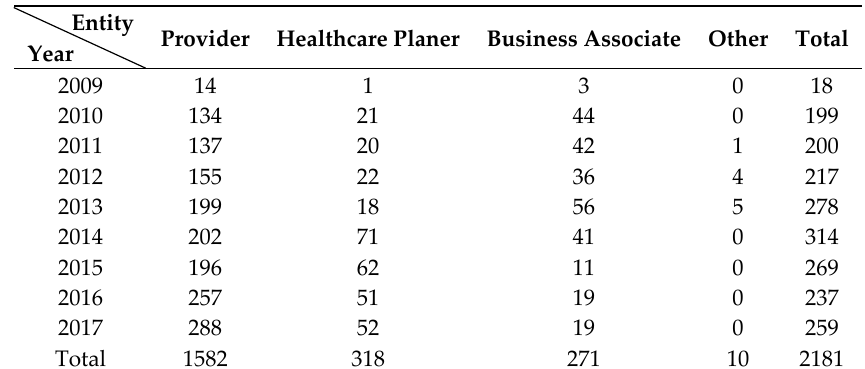
Table 1. Responsible institutions for the healthcare data breach.